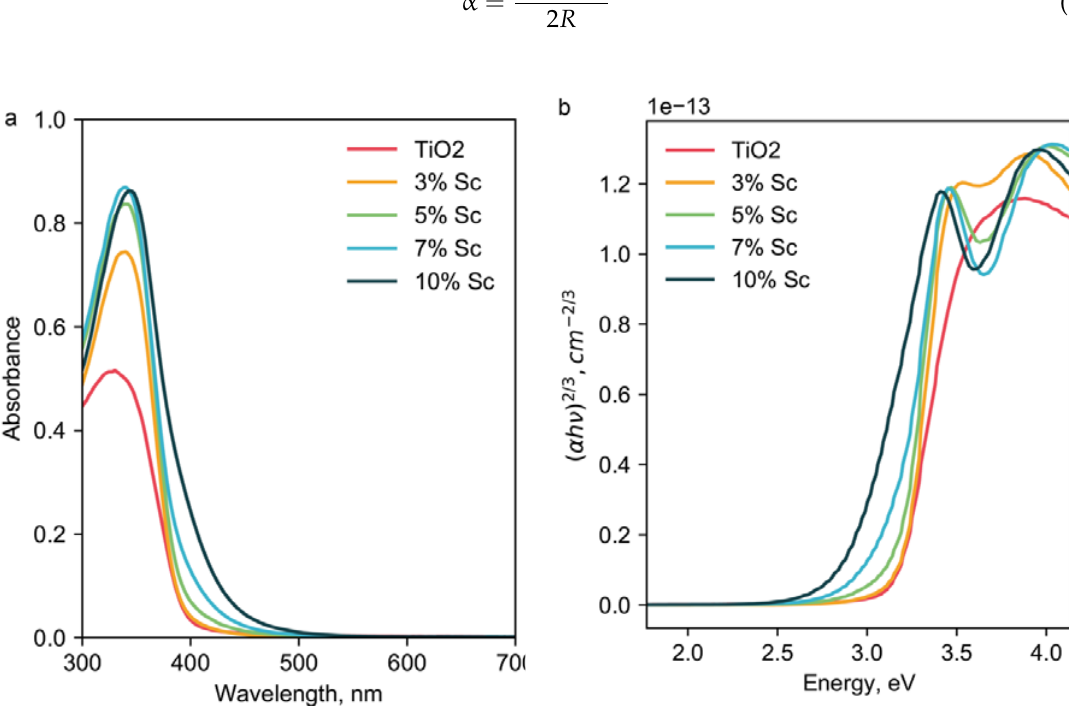
Figure 3. Absorbance spectra of pure and doped samples of TiO 2 ( a ), Tauc plot ( b ). Table 2. Experimental values of the optical forbidden bandgap E g for pure and Sc ‐ doped titania obtained from the Tauc plot.